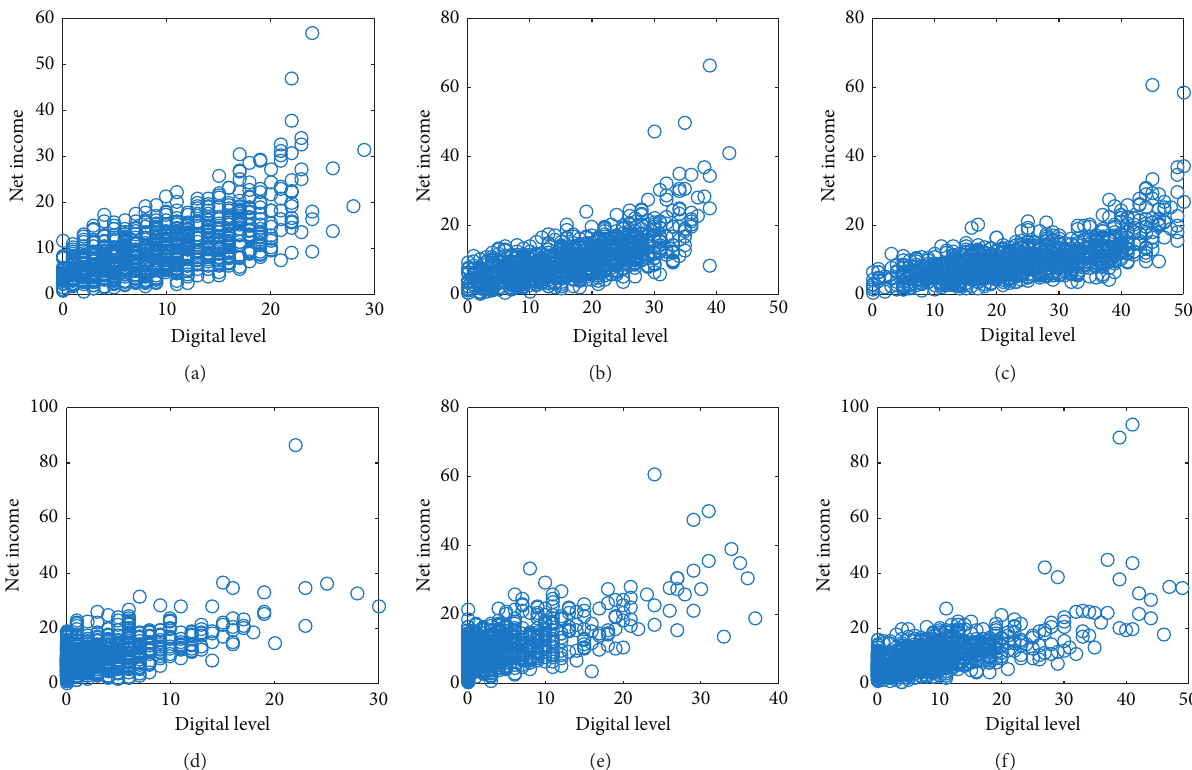
Figure 9: Enterprises’ net income under different demand-side policies: (a) p 1 � 0.3, Cu � 1, Cb � 2; (b) p 1 � 0.5, Cu � 1, Cb � 2; (c) p 1 � 0.7,